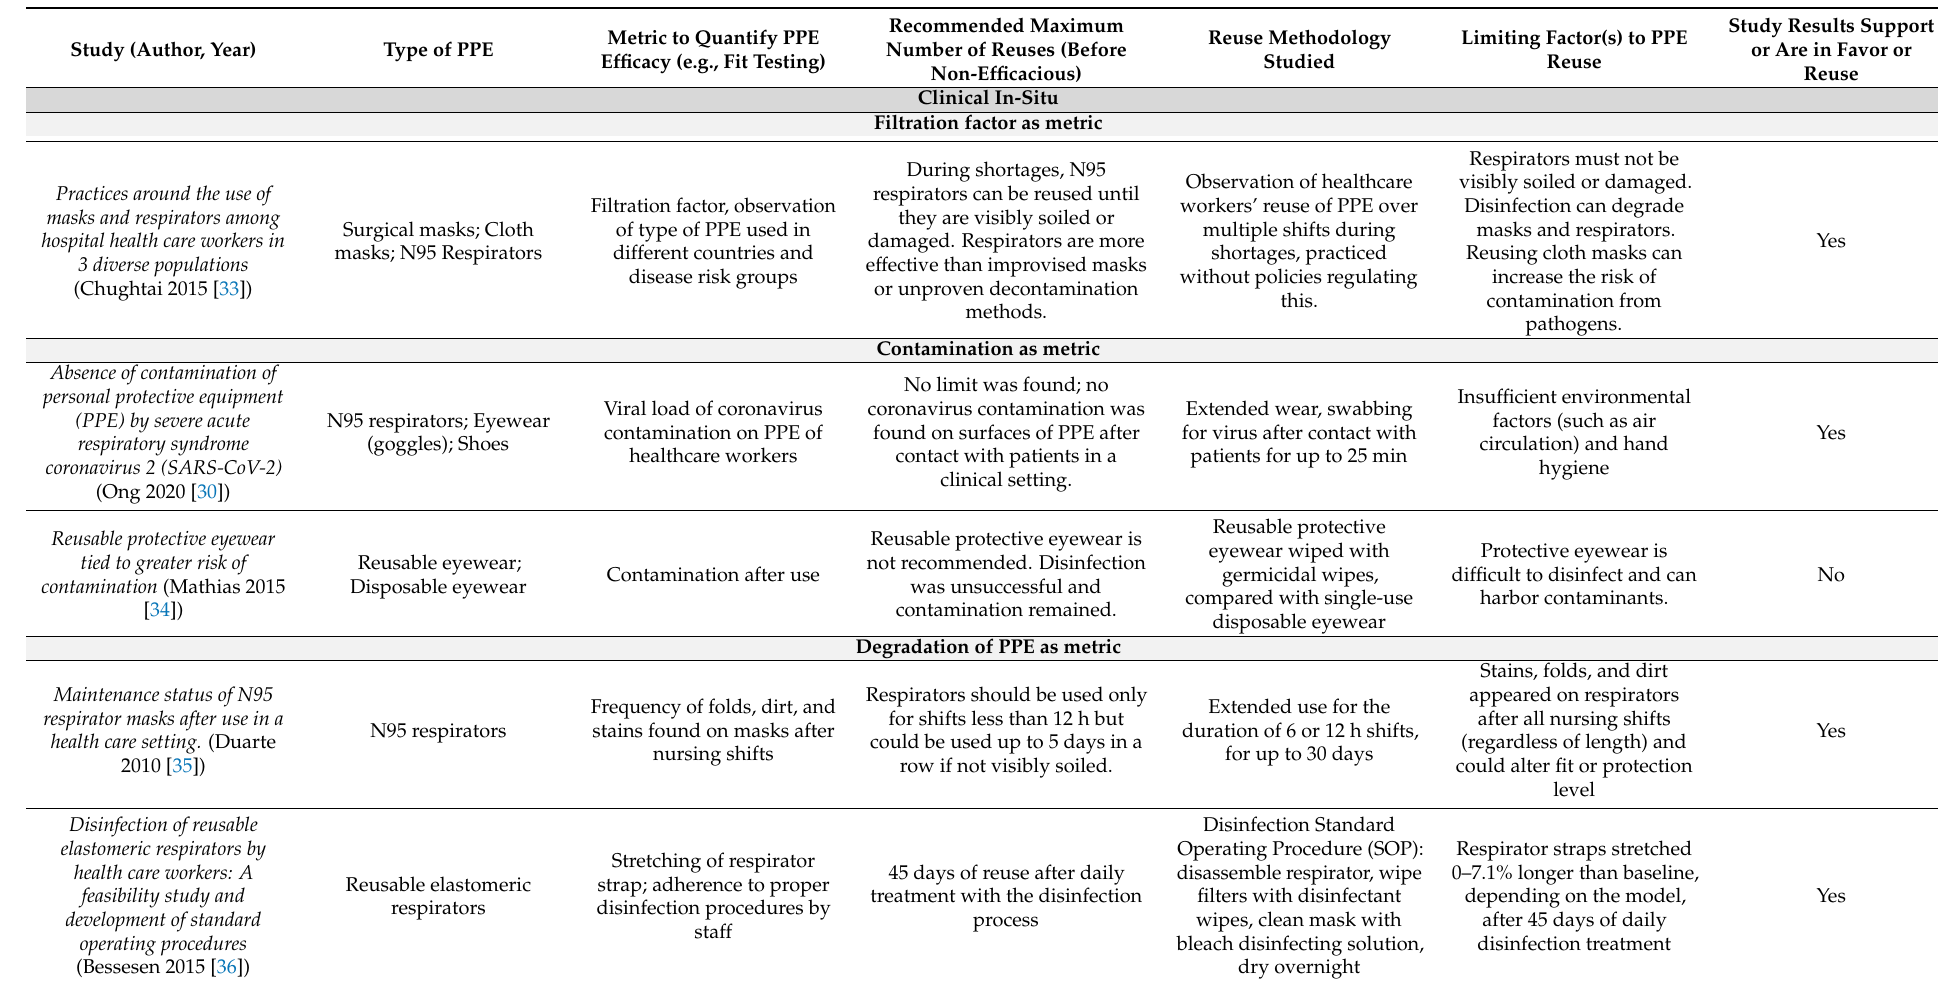
Table 1. Extended use or multiple use of single-use